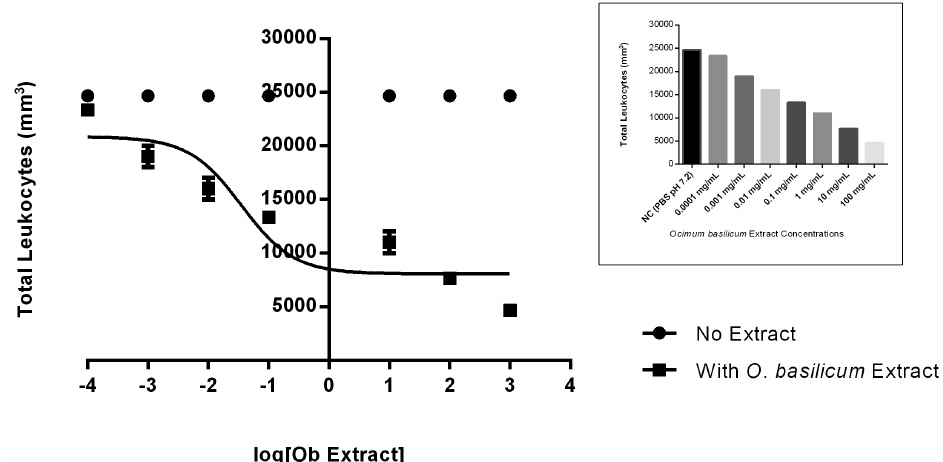
FIGURE 1 - Dose-effect curve using the crude extract of Ocimum basilicum in different doses (0.0001 mg/mL to 100 mg/mL) to determine the lethal dose 50 (LD ) in human leukocytes. The inset shows the total amount of leukocytes versus the tests 50 concentrations of O. basilicum